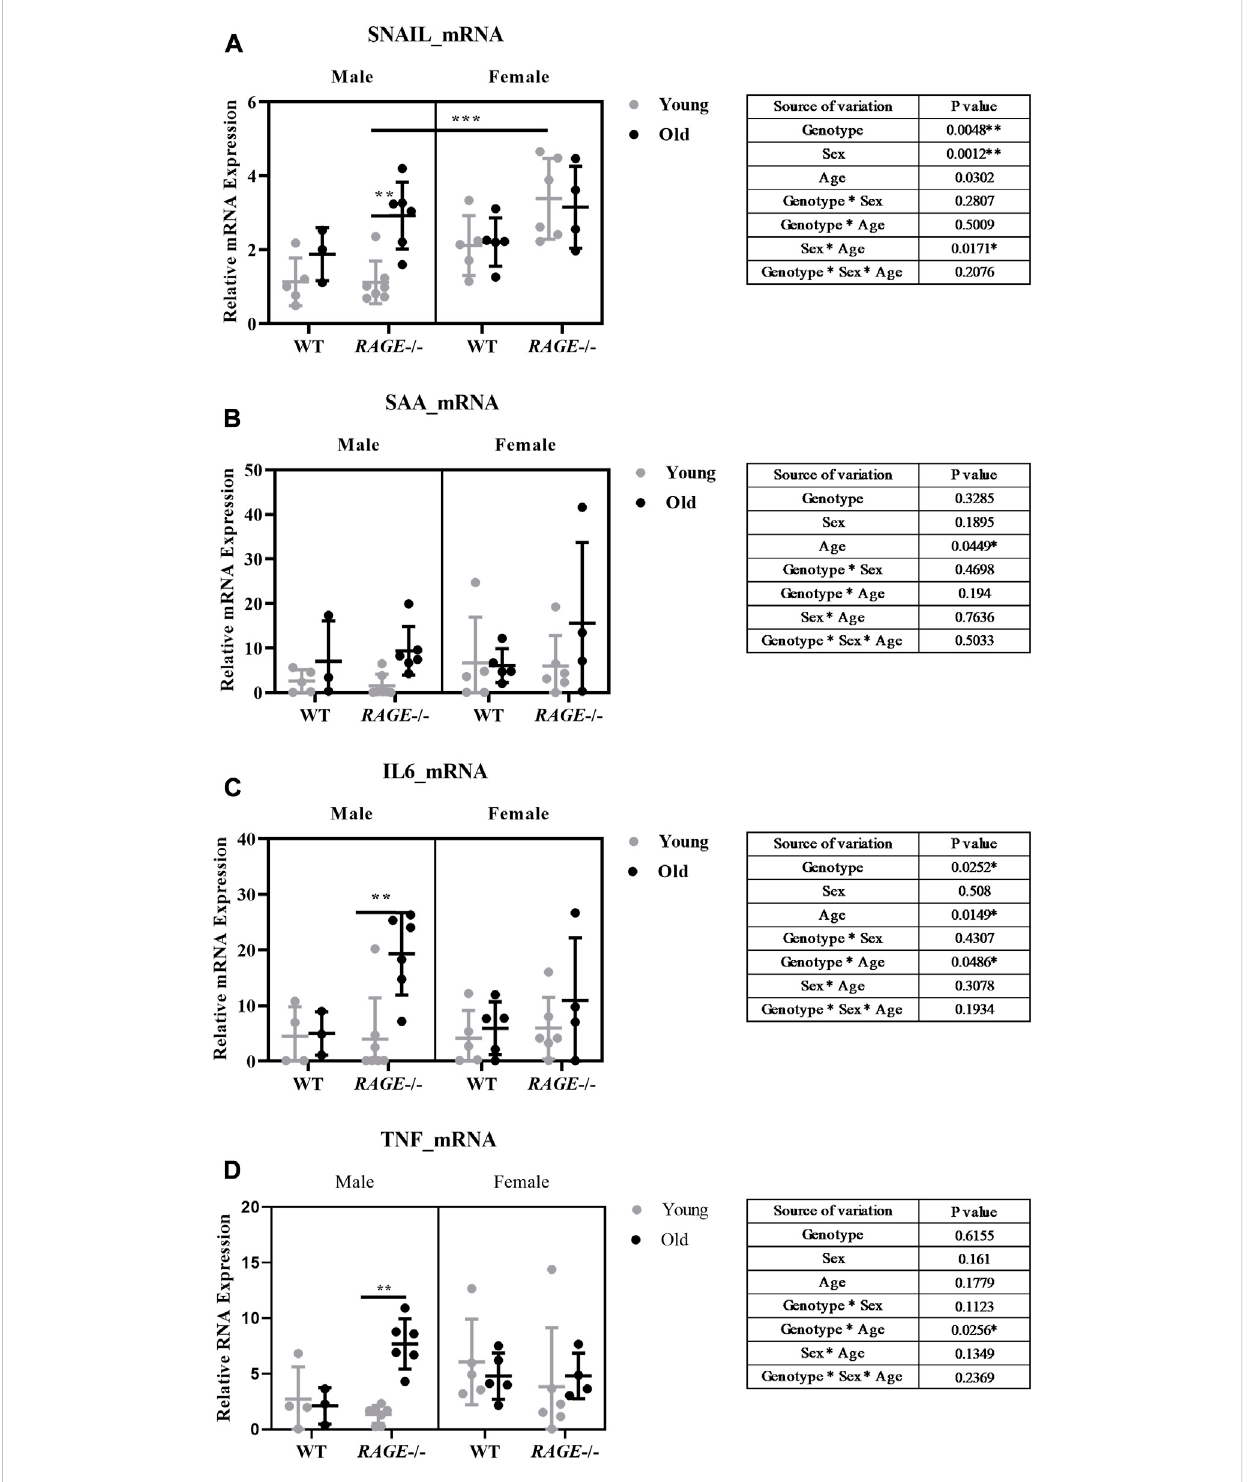
FIGURE 5 Expression of pro- fi brotic/pro-in fl ammatory markers in the mouse kidney: mRNA quanti fi cation by q-PCR for (A) SNAIL, (B) SAA, (C) IL-6, and (D) TNF.Signi fi canceandinteractionwerecalculatedbythree-wayANOVAwithgenotype(wildtype vs. RAGE − / − ,sex(male vs. female),andage(young vs. old) as three factors (shown as table insert). Sidak multiple comparisons tests were performed for intergroup signi fi cance (shown above bars). Young ( < 30 weeks)andold( > 70 weeks)maleandfemalemice( n =3 – 7)wereusedintheexperiment.Dataareshownasmean±SD; p- value:0.05*,0.01**, 0.001***, and